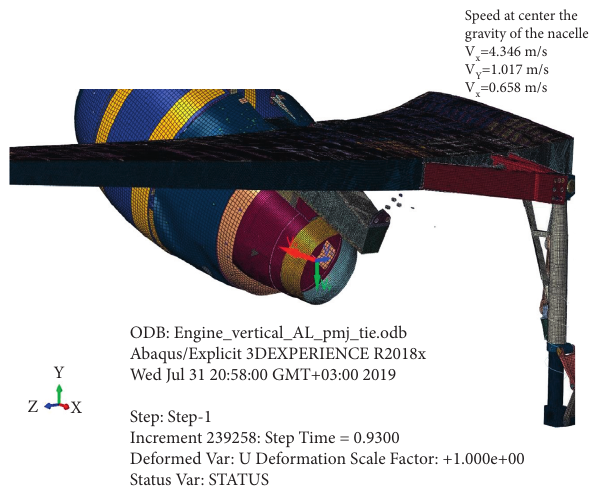
Figure 24: Deformation after emergency break—vertical impact.